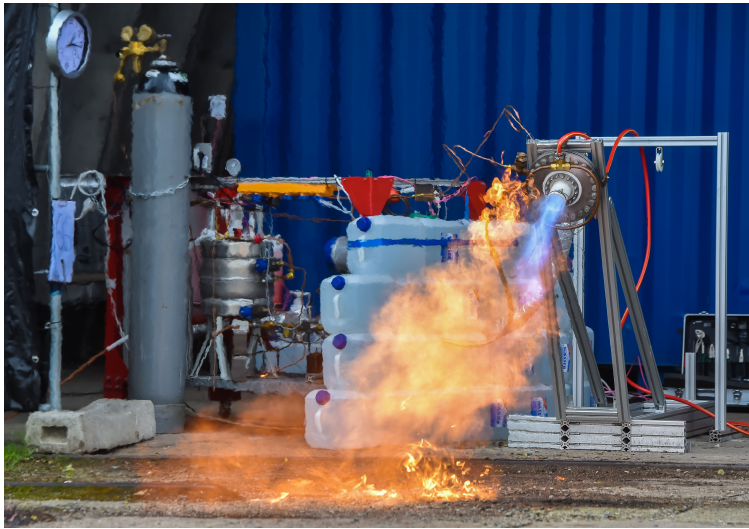
Figure 5. Hot test of the flame tube carried out with the engine test rig ©Holm